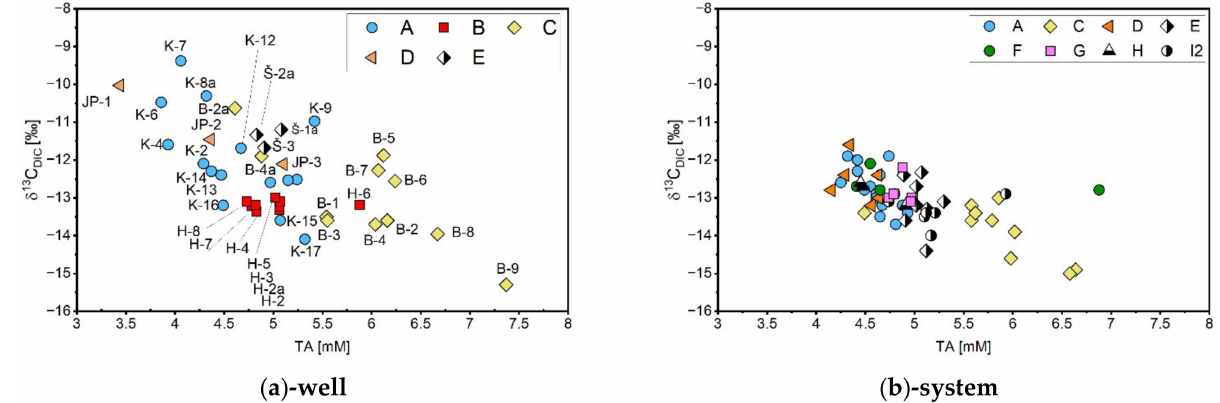
Figure 7. Relation between δ 13 C DIC and TA for samples collected from wells (N = 41) ( a ) other components of the WSS system (N = 63) ( b ). A = Kleˇce, B = Hrastje, C = Brest, D = Jarški prod, E = Šentvid, F = Hrastje/Jarški prod, G = Kleˇce/Brest, H = Kleˇce/Hrastje/Jarški prod and I2 =